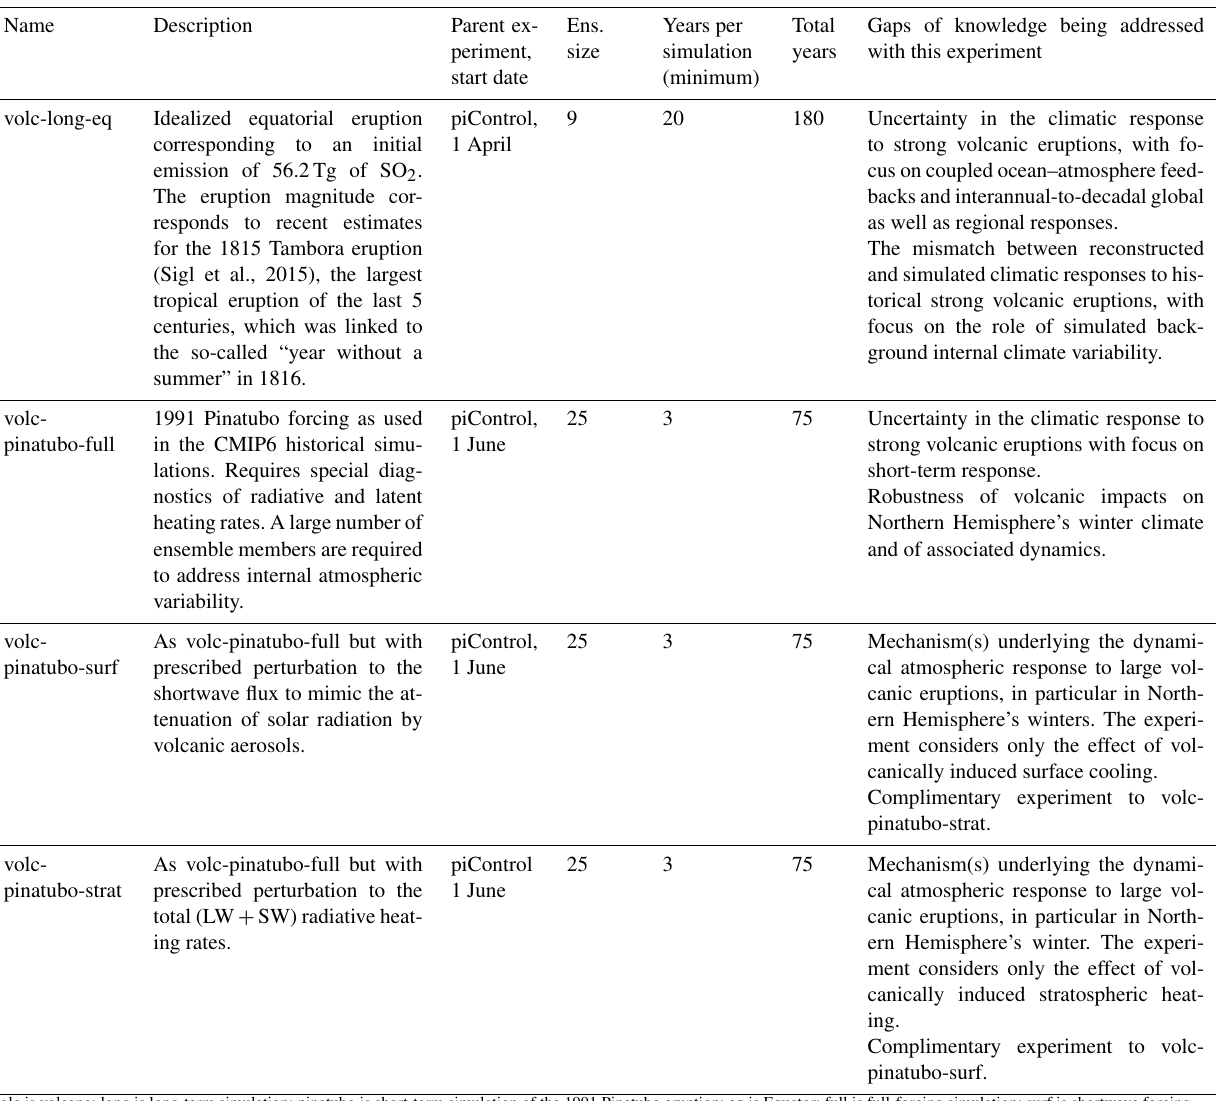
Table 1. Tier 1 VolMIP